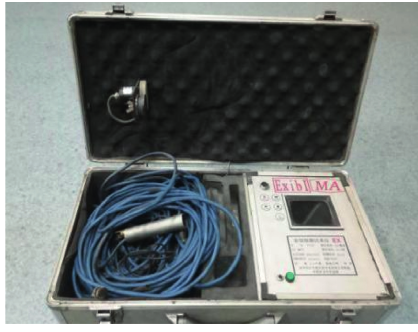
Figure 6: Drilling imager. Table 1: Results of geostress measurement.